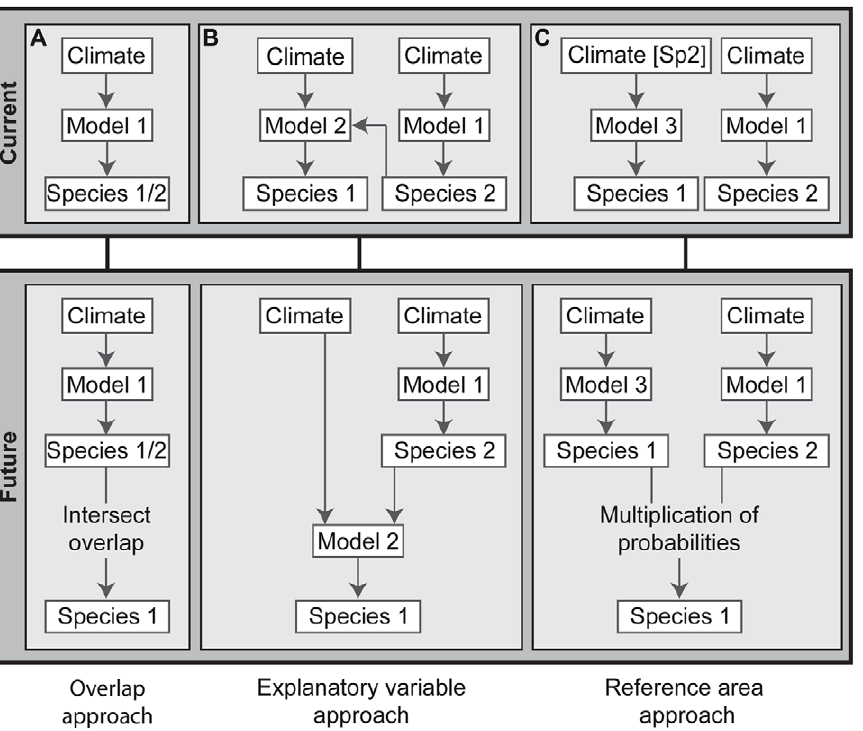
Figure 2. Conceptual framework of the three applied approaches for modelling biotic interactions. A) ‘Overlap approach’: modelling both species separately and intersecting the future range overlap. B) ‘Explanatory variable approach’: modelling the dependent species with the essential species as additional explanatory variable. C) ‘Reference area approach’: modelling the dependent species in the range of the essential species and multiplication of the occurrence probabilities of both species. Species 1: dependent species (here: Aeshna viridis ), Species 2: essential species (here: Stratiotes aloides ), Climate [Sp2]: restriction of climatic reference area of species 1 to the current distribution of species 2.